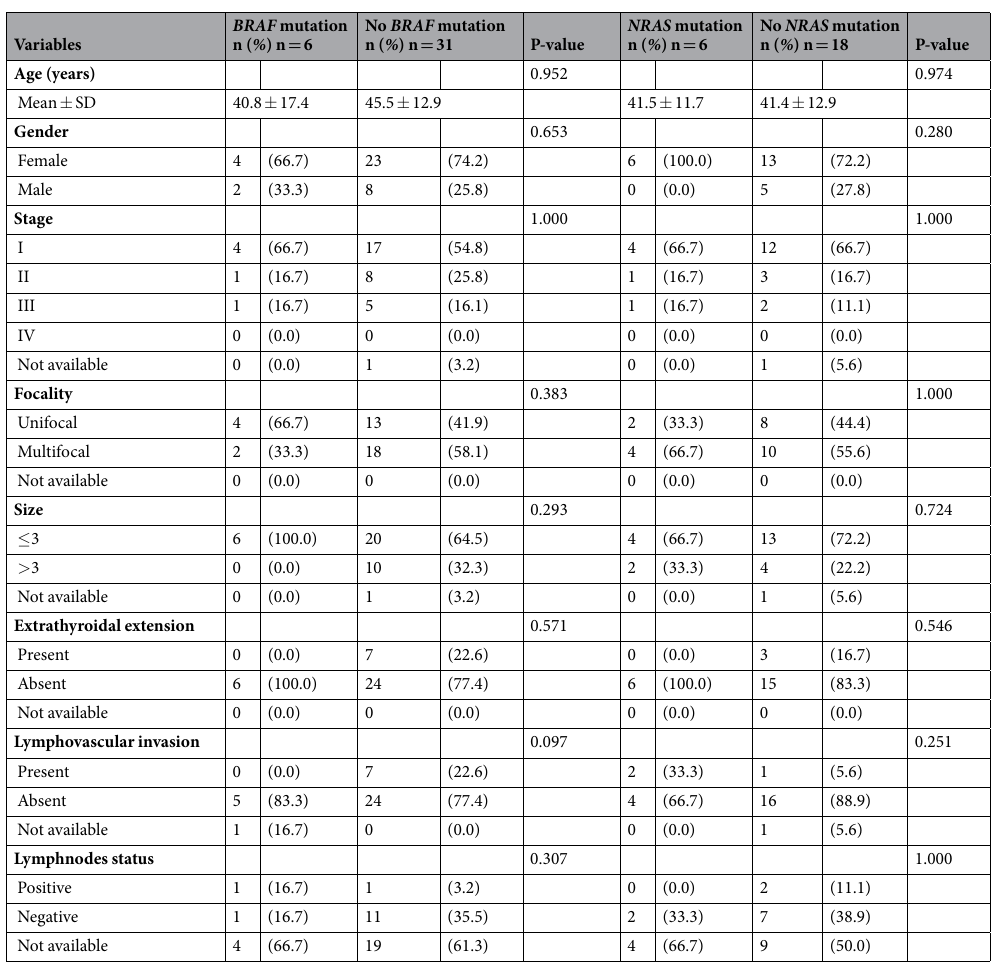
Table 5. Clinicopathological features of PTC-FV cases with respect to BRAF and NRAS mutations. * Significant